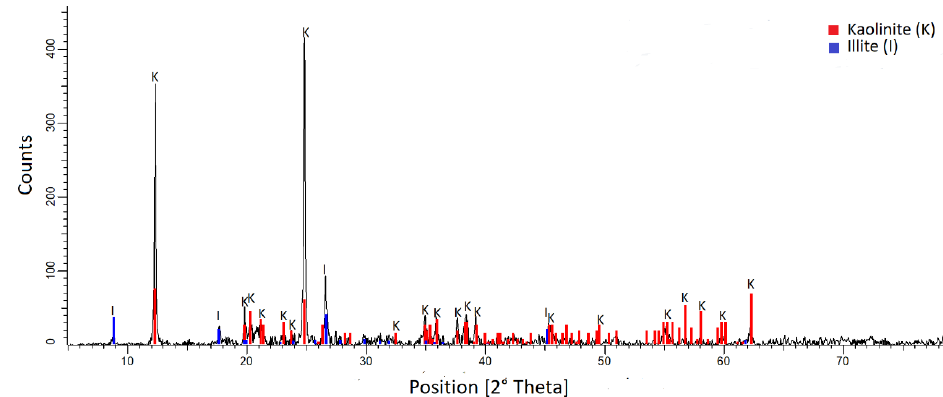
Figure 1. Kaolin X-ray diffractogram.